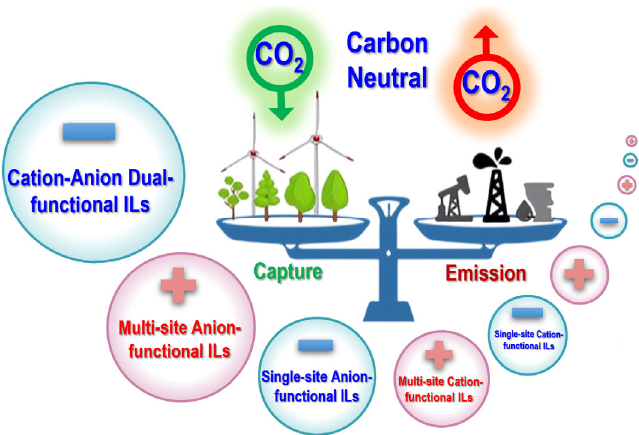
Figure 1. A summary of different kinds of functionalized ILs for CO 2